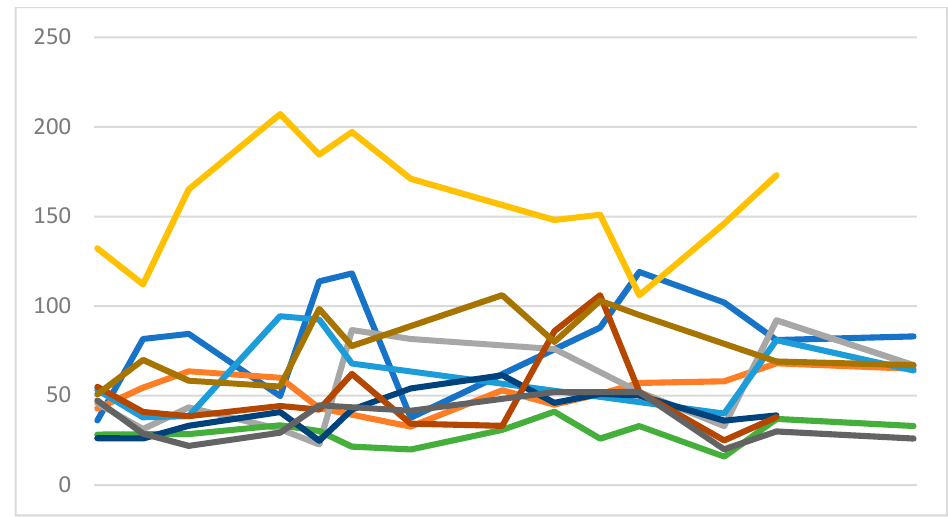
Figure 3. rMSSD. Each line represents the measurement of one player over time. Unit of measure: Milliseconds. The x axis represents the weeks of measurement. rMSSD: Square root of the mean of the sum of the squares of differences between adjacent normal-to-normal intervals.